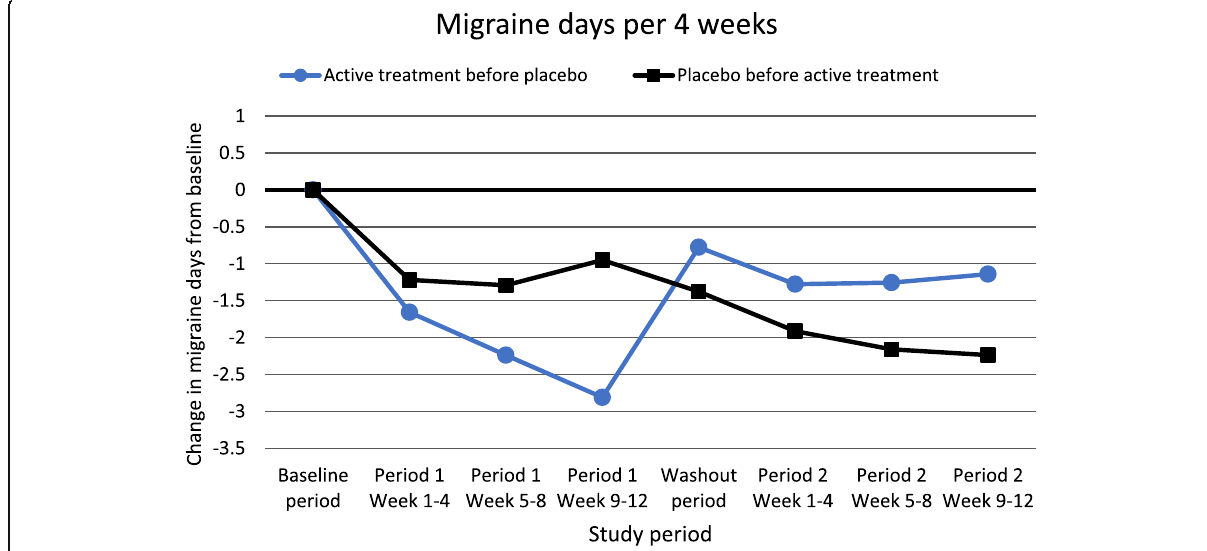
Fig. 1 Migraine days per 4 weeks in relation to treatment sequence (square: Placebo first, n = 80; circle: Active treatment first, n = 96). Data from